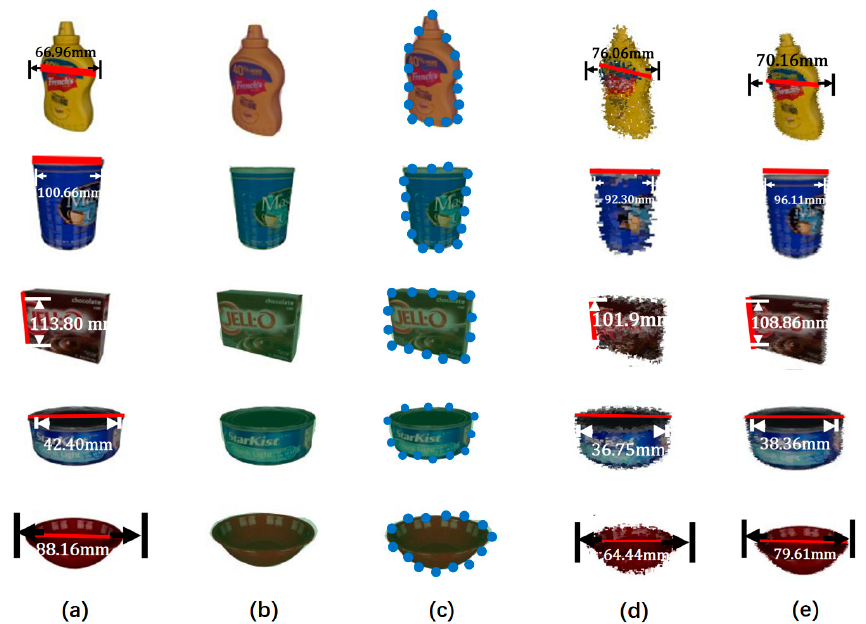
Figure 5. Extract and reconstruct samples of some objects in the experiment. ( a ) RGB image; ( b ) YOLACT++ segmentation results; ( c ) Schematic diagram of selected contour points; ( d ) NN result; and ( e ) BCC-Drop results.